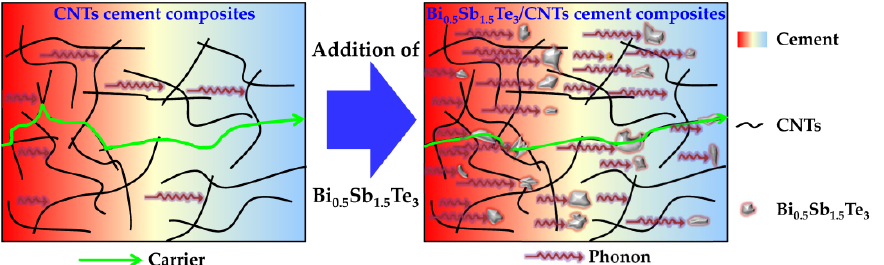
Figure 11. A schematic mechanism for multi-scale Bi 0.5 Sb 1.5 Te 3 particles in enhancing the TE performance of CNTs reinforced cement composites.